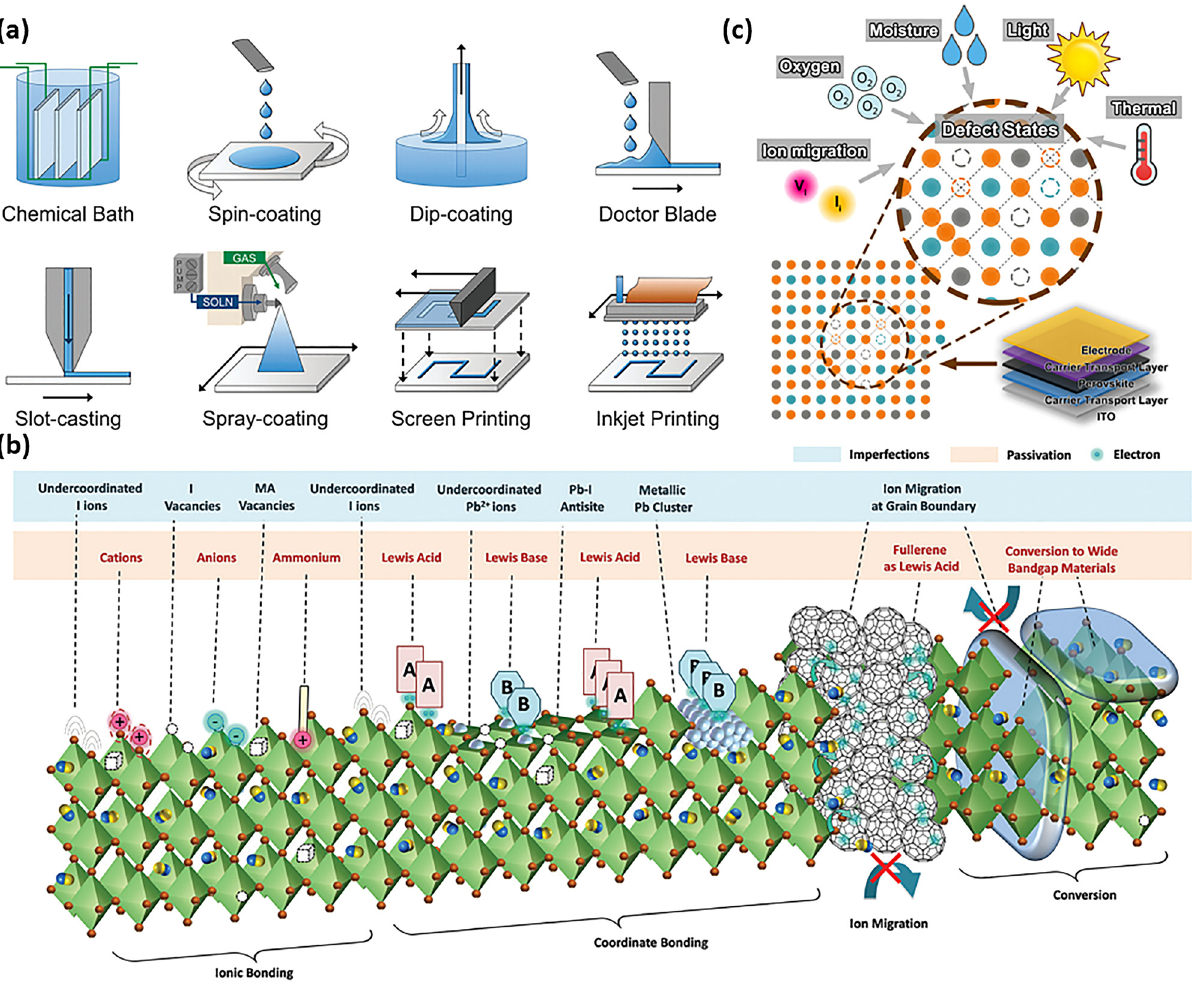
Figure 8: Schematic on the (a) various types of solution-based processing techniques with applicability to perovskites. Adapted with permission from [214]. (b) Types of defects present in perovskites and passivation routes to mediate them. Adapted with permission from [215]. (c) Mediation of perovskite degradation by crystal lattice defects. Adapted with permission from